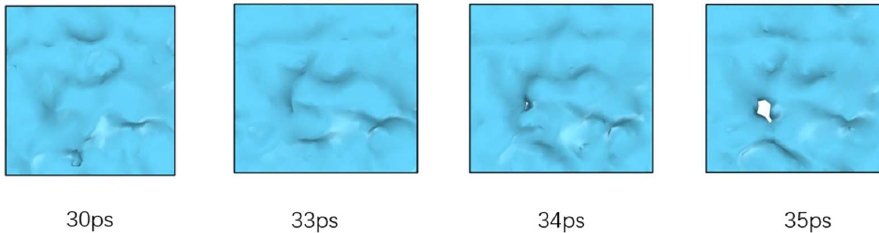
Figure 13. Crack surface contact picture (blue color is the projection of crack blank area in X-Y section; white area is the asphalt binder fragment surface contact area).